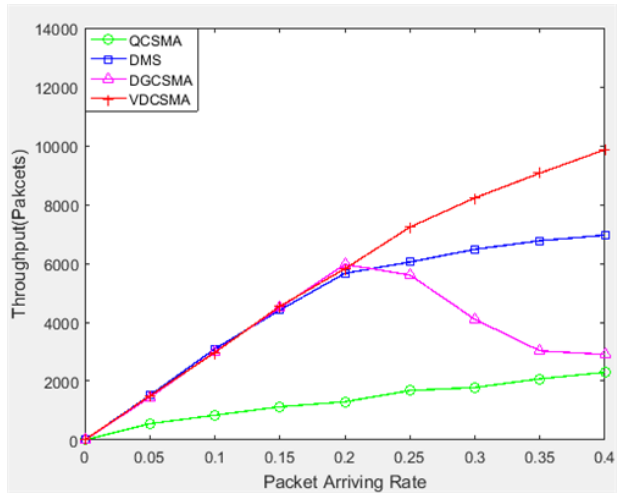
Figure 5. Throughput of real-time links: λ ∈ [ 0,0.4 ] .